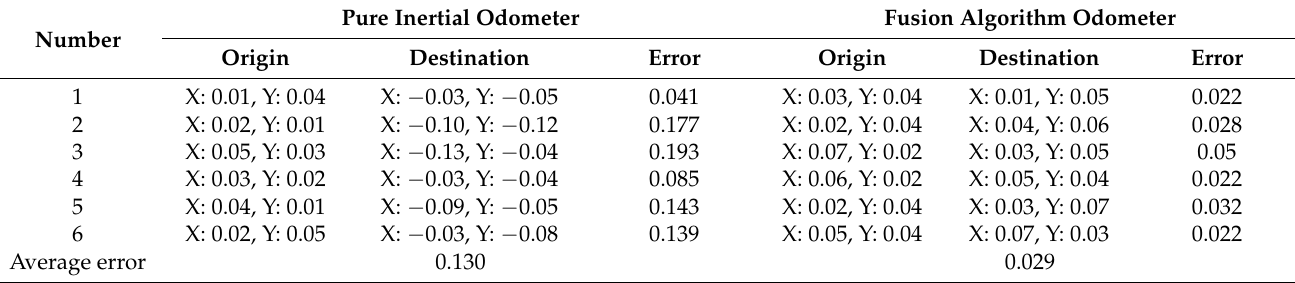
Table 2. The comparison of error before and after sensor fusion.